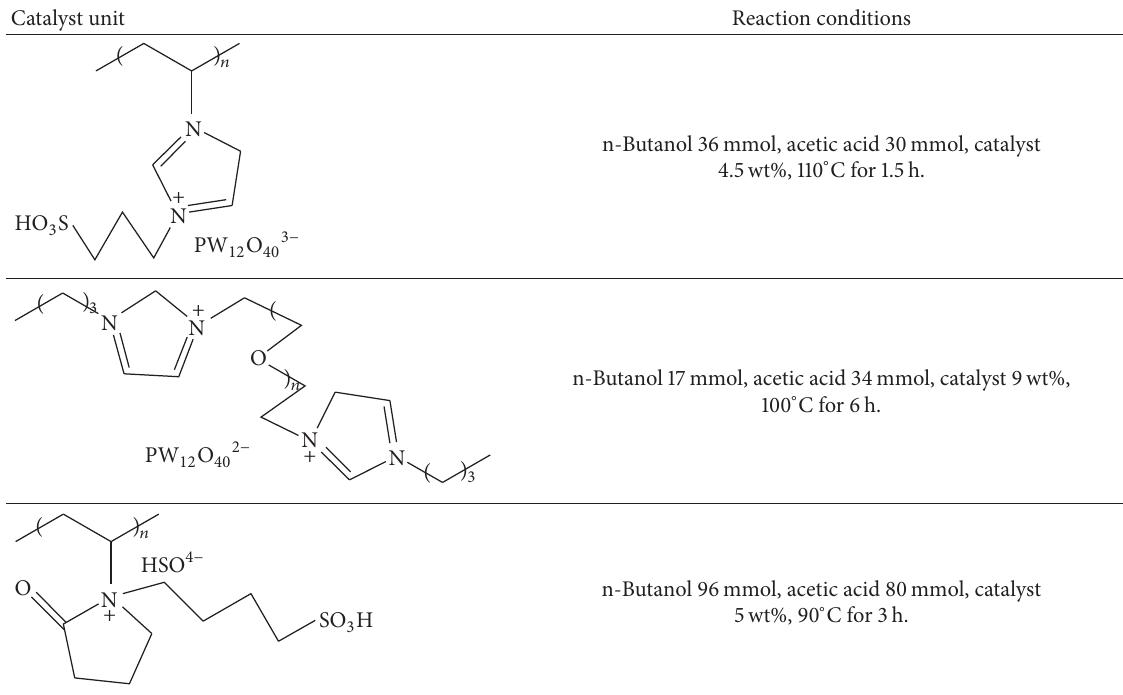
Table 3: Esterification of n-butanol and acetic acid with different polymer supported